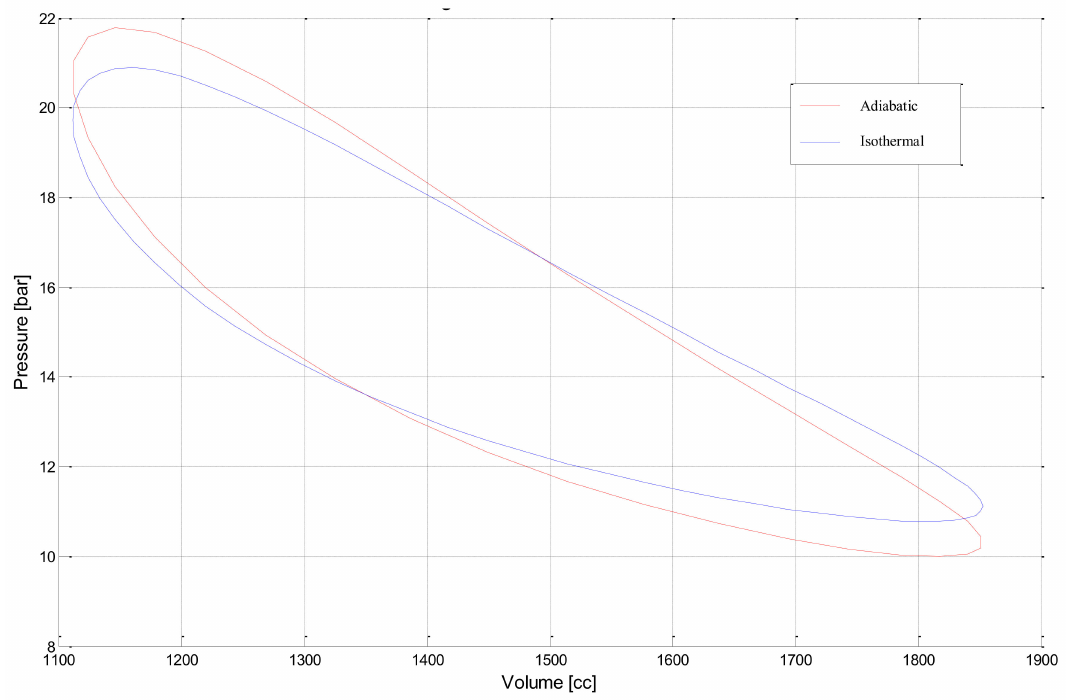
Figure 14. Pressure diagrams of isothermal and adiabatic cycle